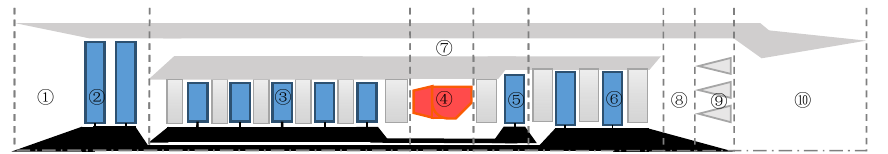
Figure 4. 2-spool mixed flow turbofan engine.